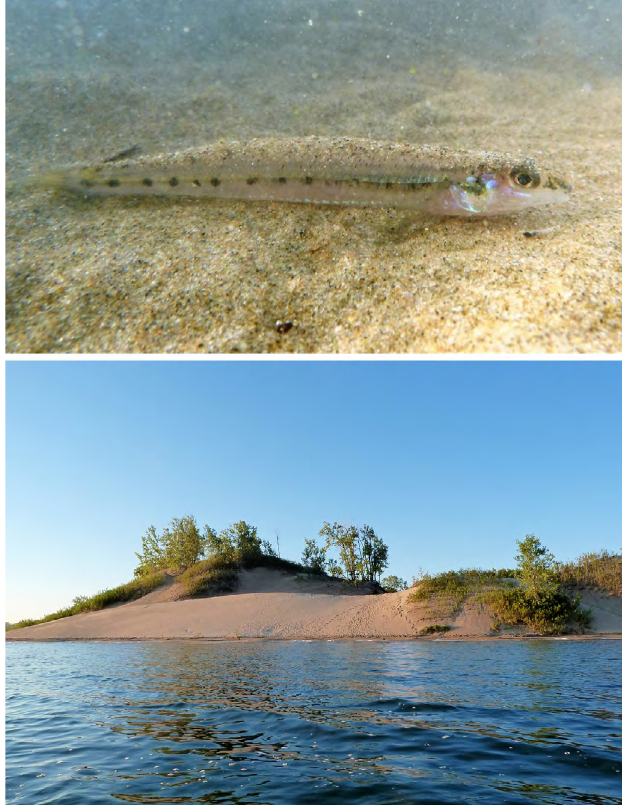
Figure 2. Adult Eastern Sand Darter (62 mm TL) collected from West Lake, Ontario, 19 September 2013 (upper) and the barrier sand dune formation adjacent to collection sites (lower). Photographs by Alan Dextrase.